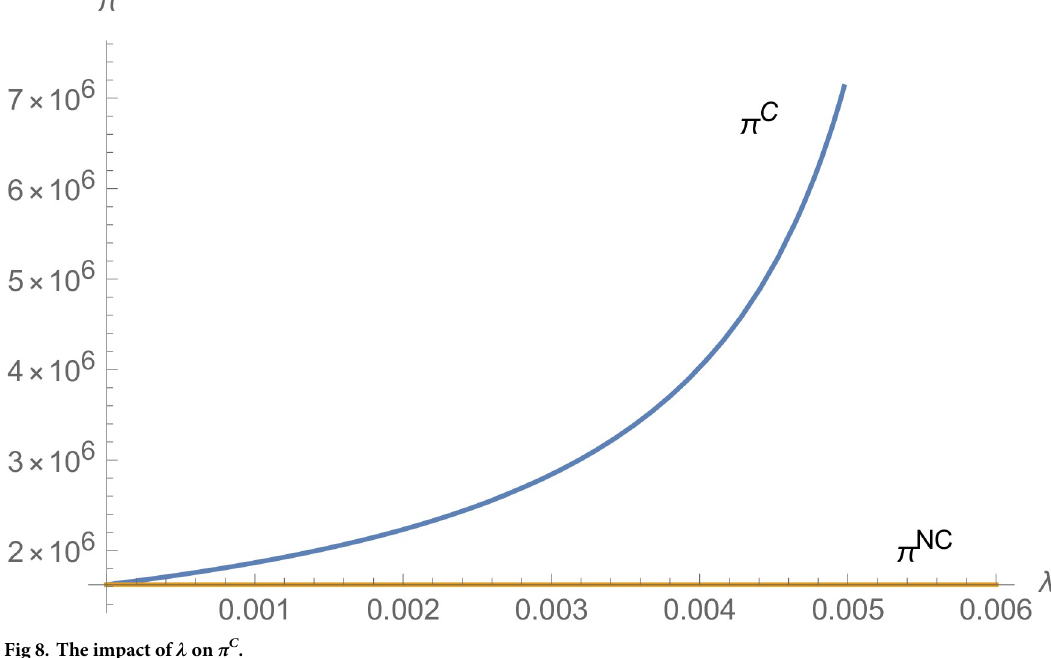
Fig 8. The impact of λ on π C